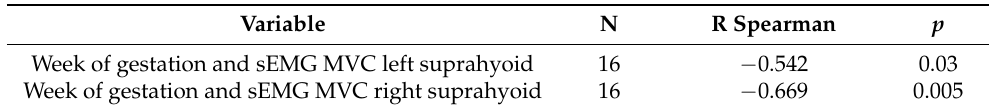
Table 2. The relationship between gestational age and maximum voluntary contraction (MVC) of left and right suprahyoid